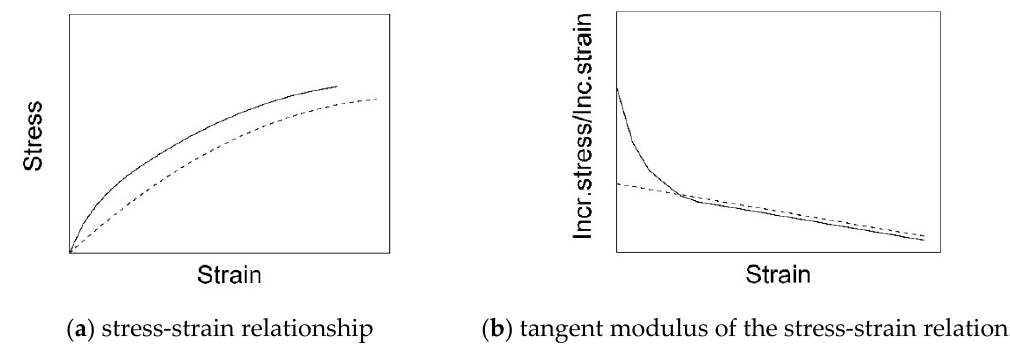
Figure 4. Typical data of static loading test on a concrete pile